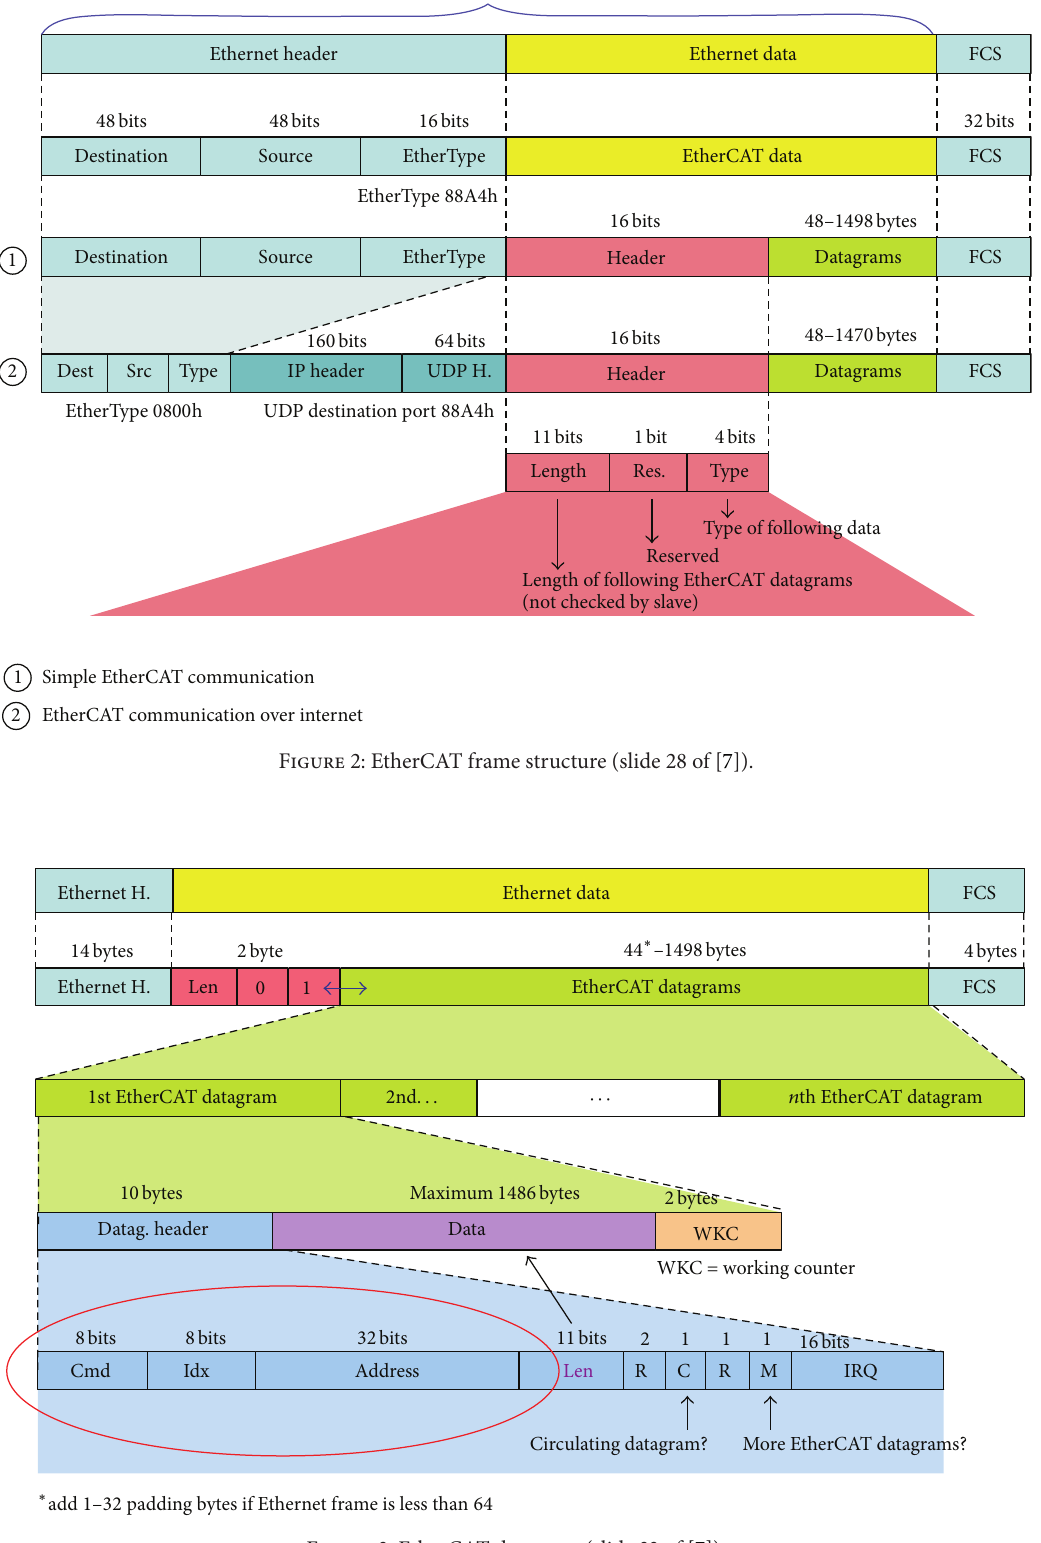
Figure 3: EtherCAT datagram (slide 33 of